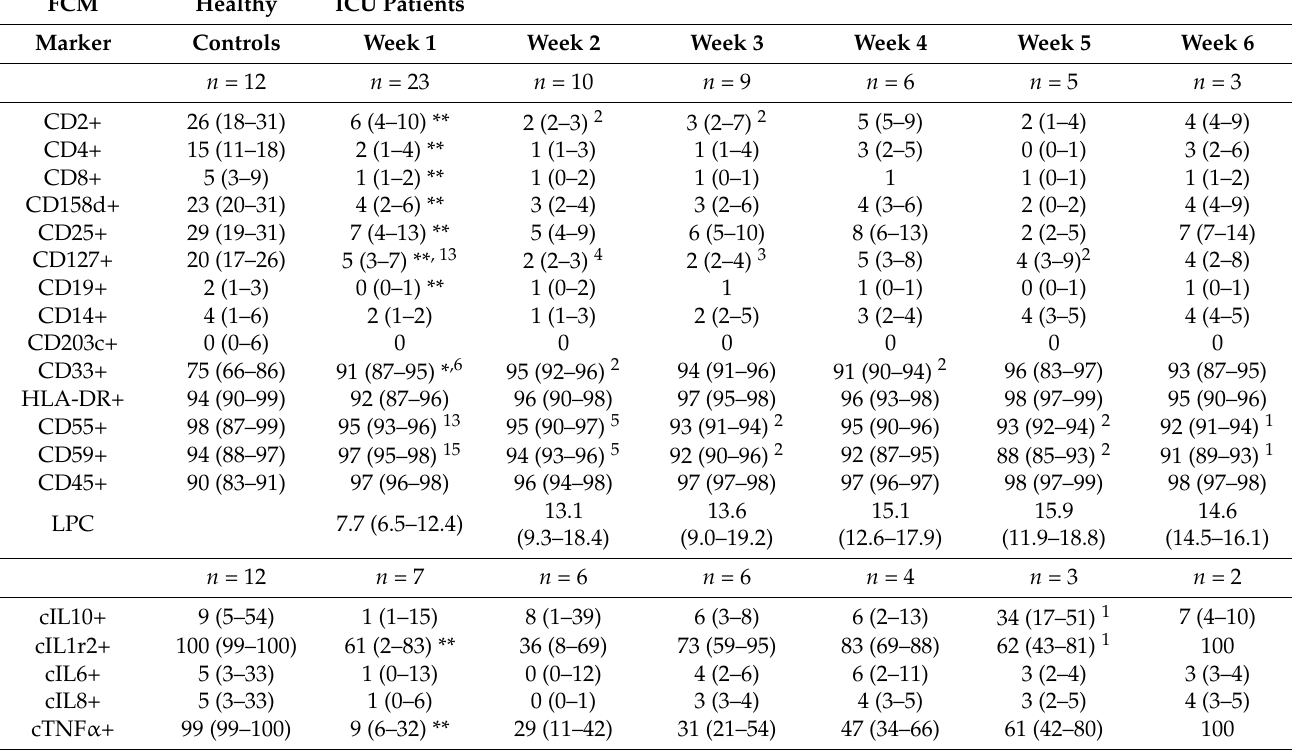
Table 2. The evolution of surface and intracytoplasmic leukocyte marker levels in the percent of total leukocytes in ICU patients and in healthy controls (HCs). The median was the interquartile range. Leukocytes were defined as positive for CD45. Absolute LPC was in the order of 10 9 cells per liter. Superscript numbers represent the number of missing